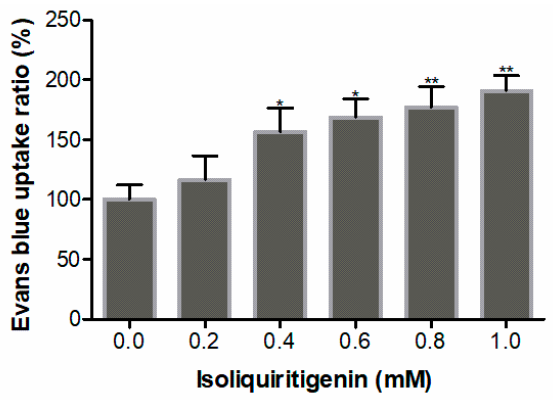
Figure 7. Relative Evans blue uptake in lettuce radicles after treatment with different concentrations of isoliquiritigenin. Values are expressed as a percentage of the mean compared to the control. Error bars are one standard deviation of the mean. N = 3. One asterisk * and two asterisks ** represent the significant difference between the isoliquiritigenin-treated lettuce radicles and the control at p < 0.05 and p < 0.01, respectively.